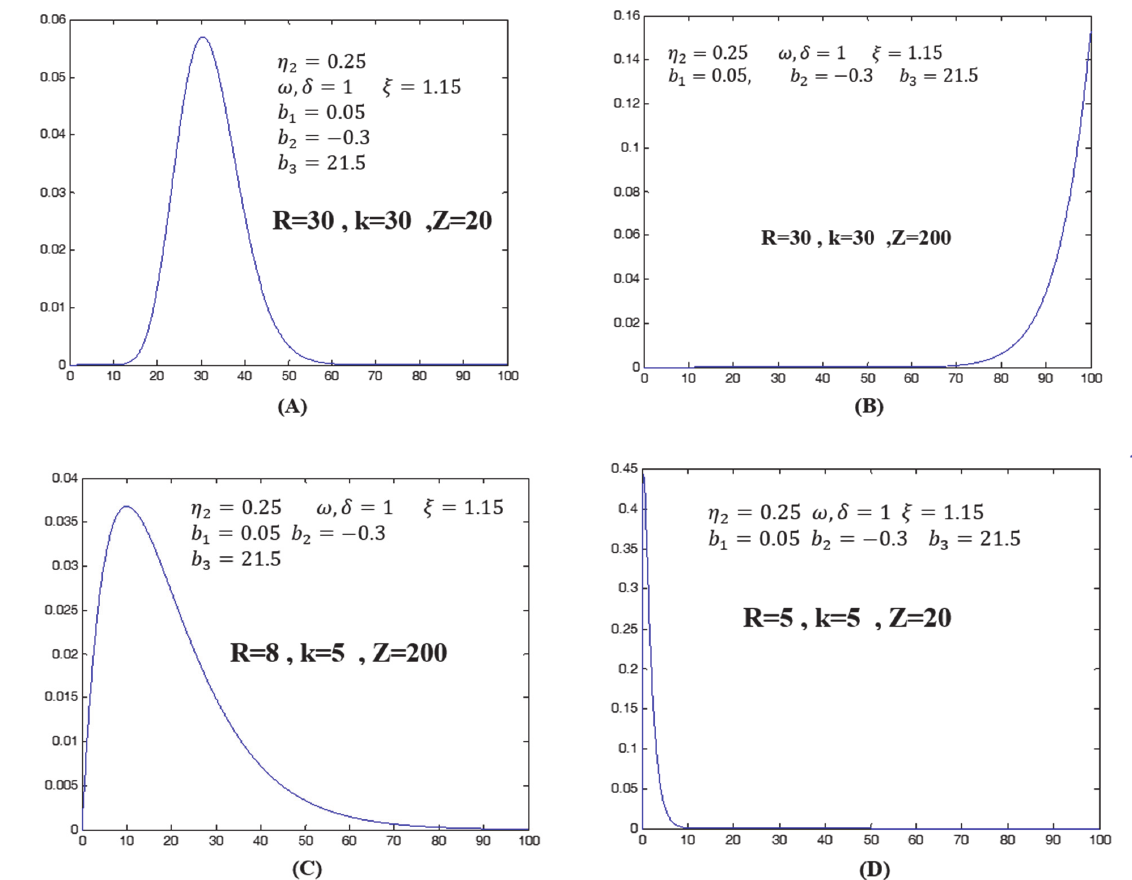
Fig. 6 . different modes (A, B, C, D) with various amounts of shock and incomplete